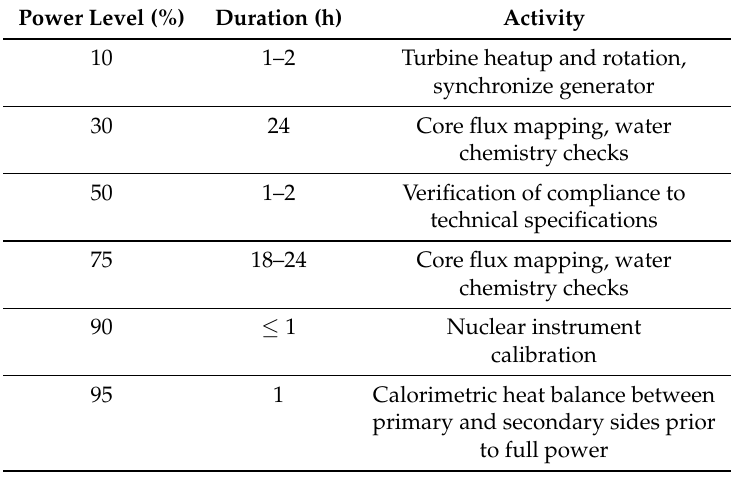
Table 2. Summary of hold points during power increase after a shutdown related to refuelling, based on data in